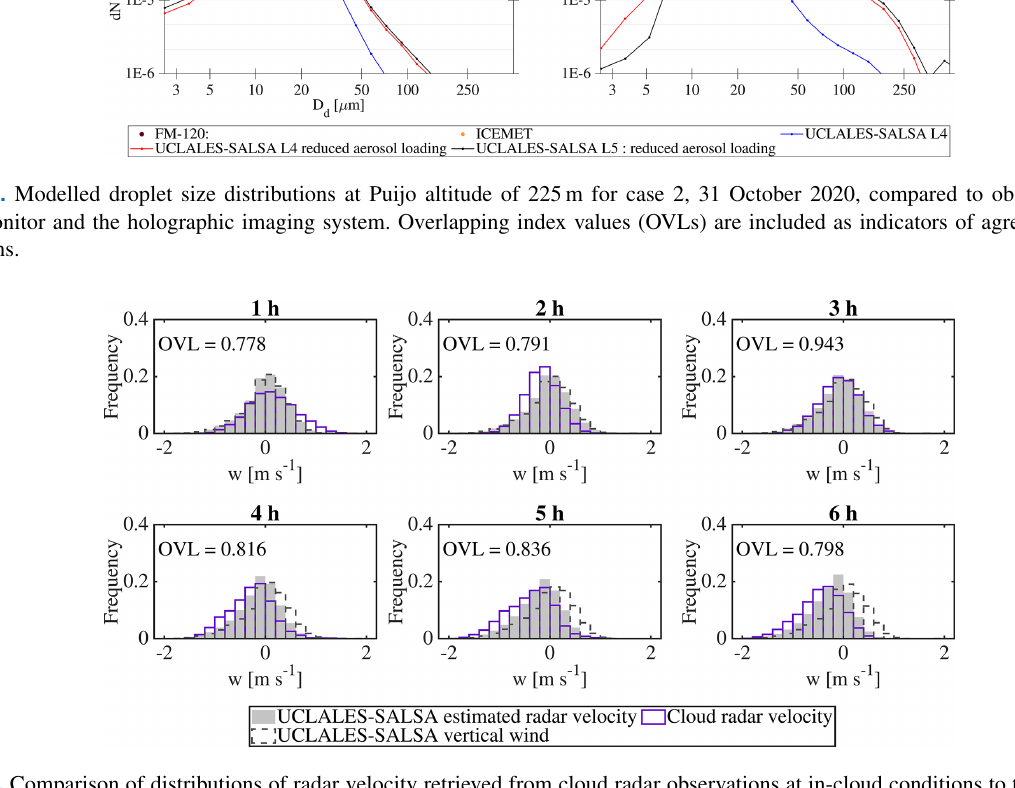
Figure 15. Comparison of distributions of radar velocity retrieved from cloud radar observations at in-cloud conditions to those calculated by UCLALES–SALSA for case 2 of 31 October 2020 in the simulation scenario with 40% reduction in aerosol loading used for model initialization without ice formation. Overlapping index values (OVLs) are included as indicators of agreement between